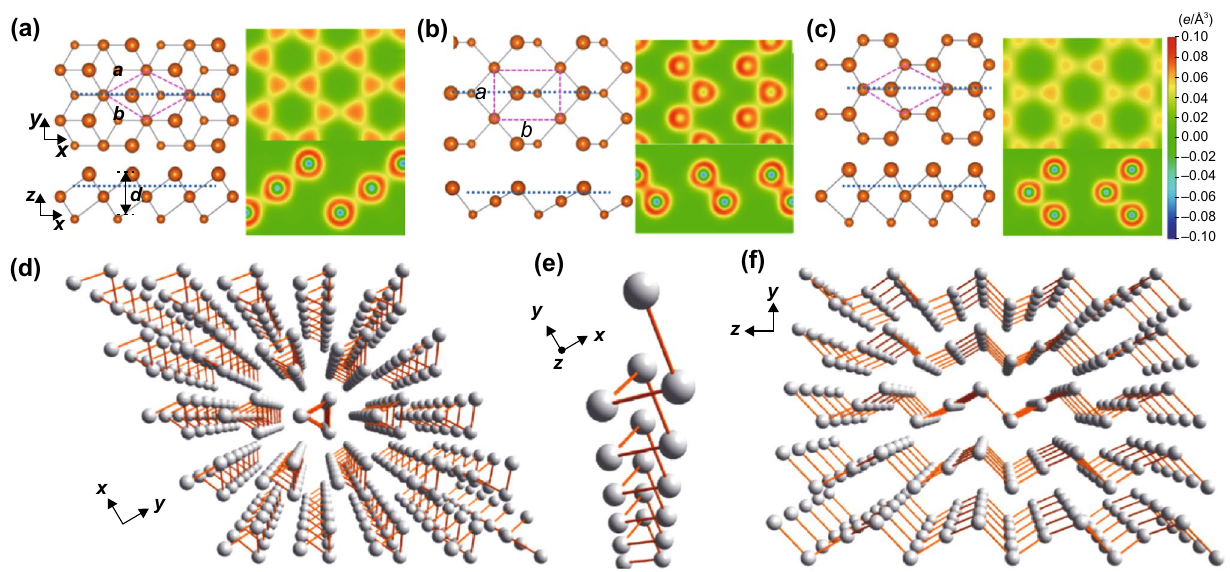
Fig. 1 a – c Structures of α‑, β‑, and γ‑Te phases. Adapted with permission from [63]. Copyright 2017, American Physical Society. d – f Crystal structure of Te viewed from the z axis, as a single‑molecule chain, and viewed from the x axis. Adapted with permission from [26]. Copyright 2018, American Chemical